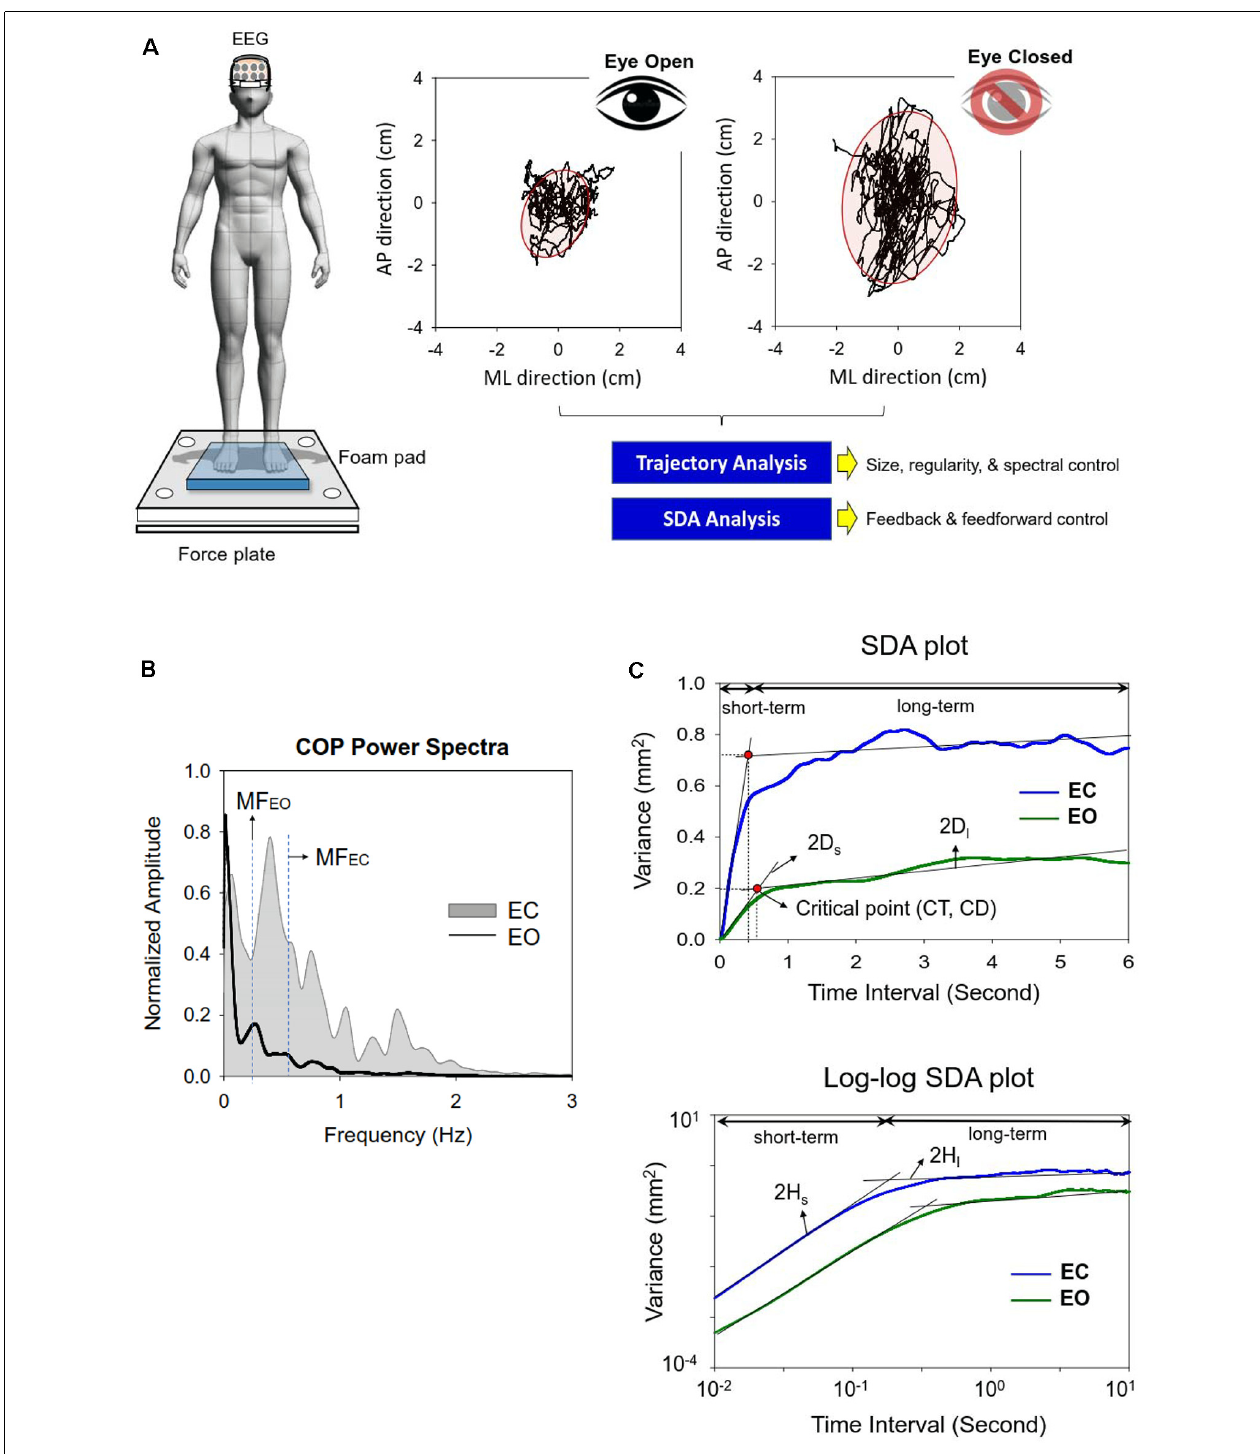
FIGURE 1 | (A) Experimental setup for measurement of the dynamics of center of pressure (COP) and EEG signals in the eyes-open and eyes-closed conditions. (B) The contrasts the COP power spectra between the eyes-open (EO) and eyes-closed (EC) conditions from a typical subject. (C) Representative linear and log–log stabilogram diffusion (SDA) plots in the EO and EC conditions. Short-term and long-term regions fitted by straight black regression lines are dominated by the open-loop and closed-loop control strategies respectively. Stabilogram diffusion parameters (D s , D l , H s , H l ) are determined by the slopes of lines fitted to short-term or long-term regions. A critical point is defined as the interaction point of the two regression lines in the short-term or long-term regions. CT, critical point of time; CD, critical point of displacement.